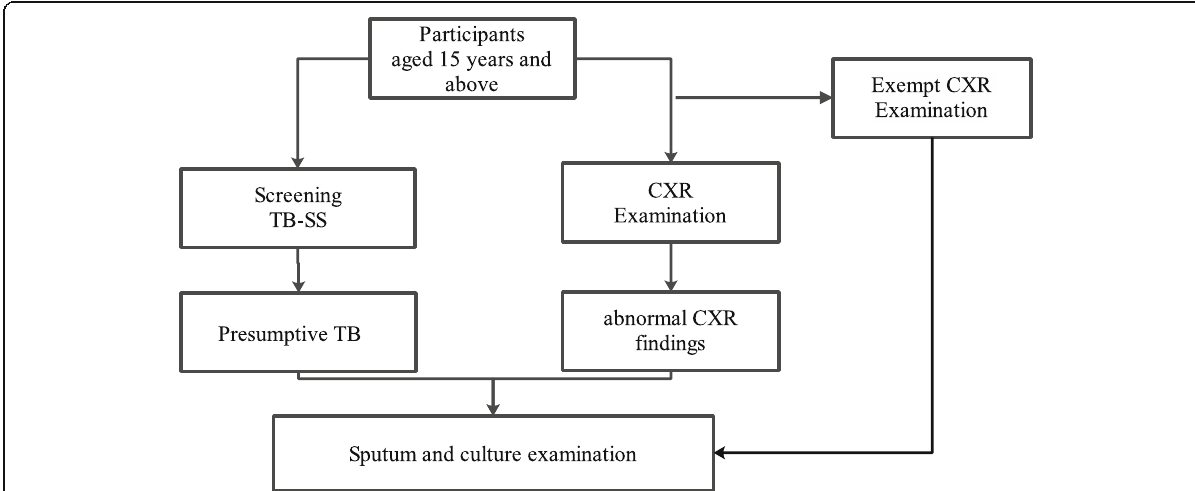
Fig. 1 Survey process for screening and diagnosis of TB among eligible participants of the household during the National TB prevalence survey. TB, tuberculosis; TB-SS, tuberculosis signs and symptoms; CXR, chest